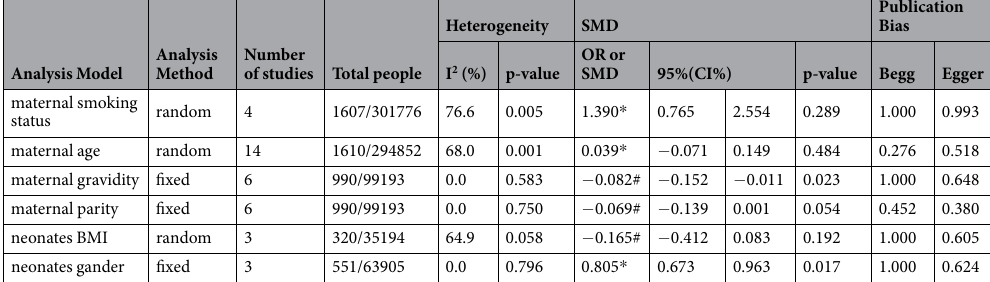
Table 2. Meta-analysis for the risk factor of isolated SUA. * : Indicates OR. #: Indicates SMD. BMI: Body Mass Index.